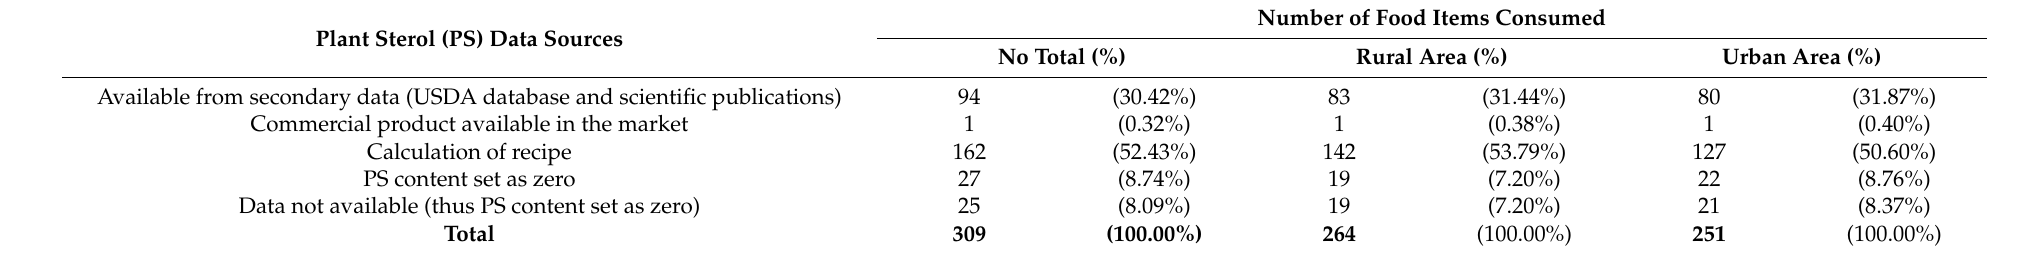
Table 3. Compositional data of plant sterol (PS) value in food items consumed by respondents. Plant Sterol (PS) Data